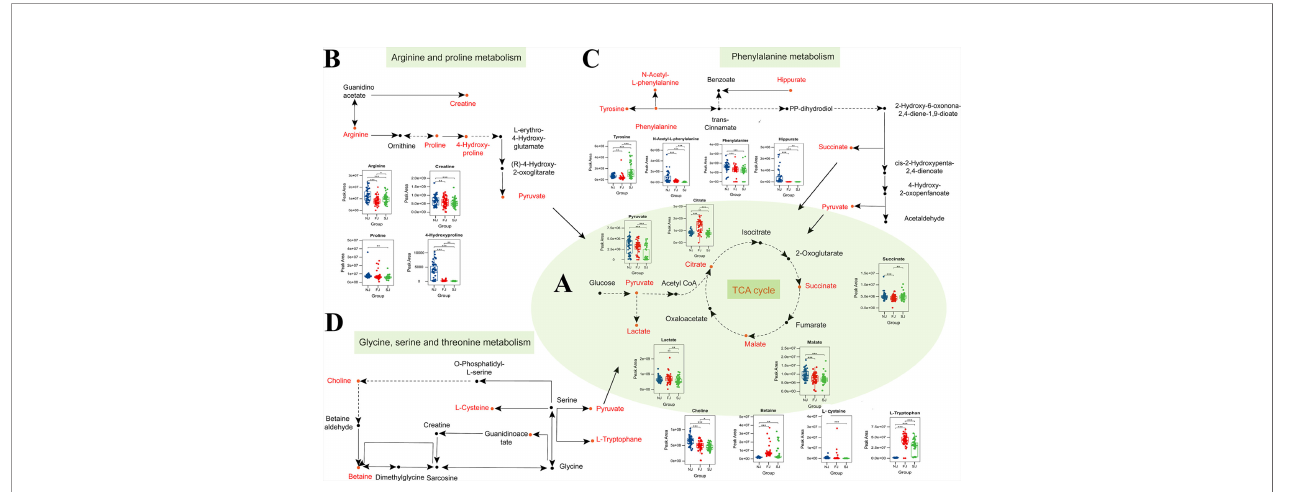
FIGURE 5 | Changes in Amino Acid Levels, Carbohydrate Levels, and Their Metabolic Pathways After Vaccination. (A) Circulating levels of TCA metabolites in plasma. Plasma levels of metabolites involved in the TCA cycle were signi fi cantly changed when comparing vaccination samples with baseline samples. (B) Signi fi cant changes were seen in the levels of some intermediates of the arginine and proline metabolism pathway in plasma of vaccine-immunized samples. (C) Signi fi cant changes were observed in the levels of some intermediates of the phenylalanine metabolism pathway in plasma of vaccine-immunized samples. (D) Signi fi cant changes were observed in the levels of metabolites involved in glycine, serine and threonine metabolism pathway after vaccination. Changed metabolites after vaccination were labeled as red. Statistical signi fi cance was determined by two-sided paired Welch ’ s t test. *p < 0.05; **p < 0.01; ***p <